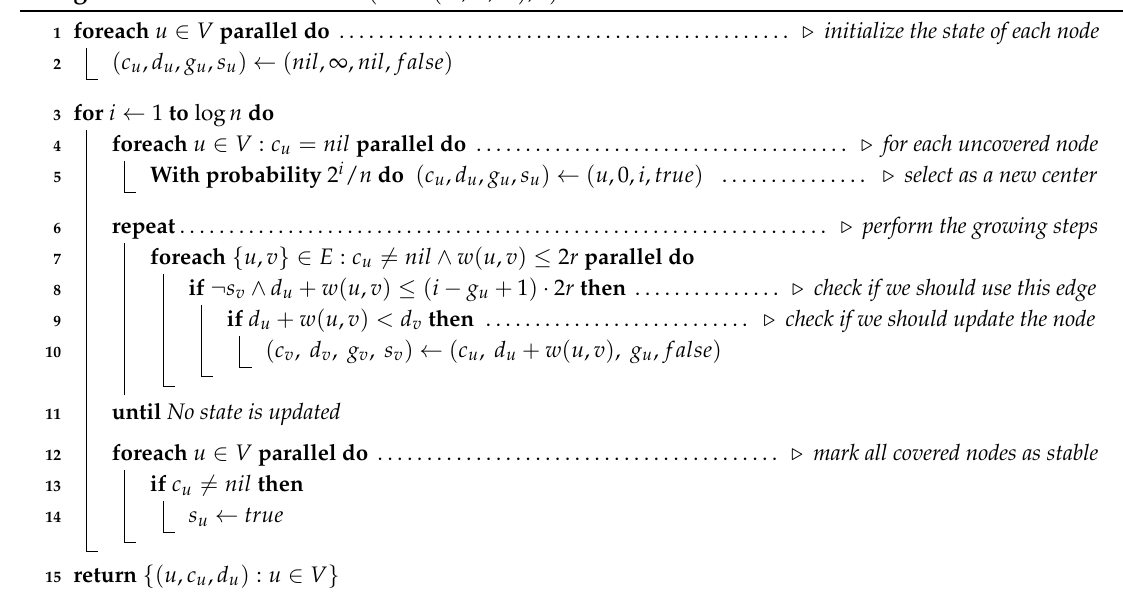
Algorithm 1: R AND C LUSTER ( G = ( V , E , w ) , r